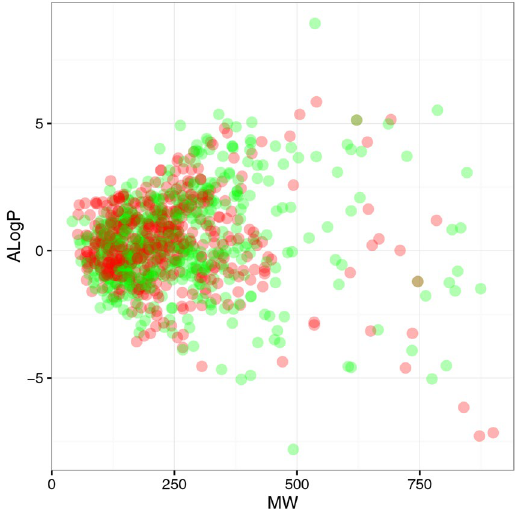
Figure 1. Chemical space of the training set. The chemical space is defined by the molecular weight (MW) on the X-axis and the logarithm of the octanol/water partition coefficient (ALogP) on the Y-axis. Carcinogens and non-carcinogens are represented by red and green dots,